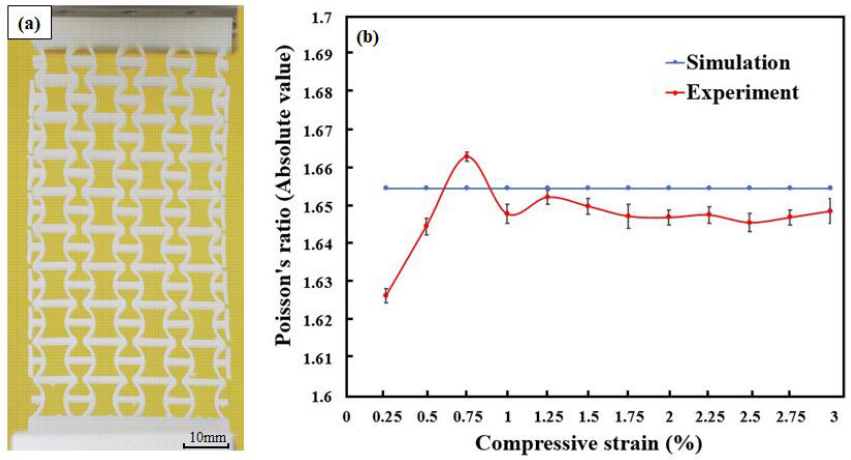
Figure 9. ( a ) Processed image of specimens under compression (strain = 0.03) and ( b ) the changes in Poisson’s ratios.